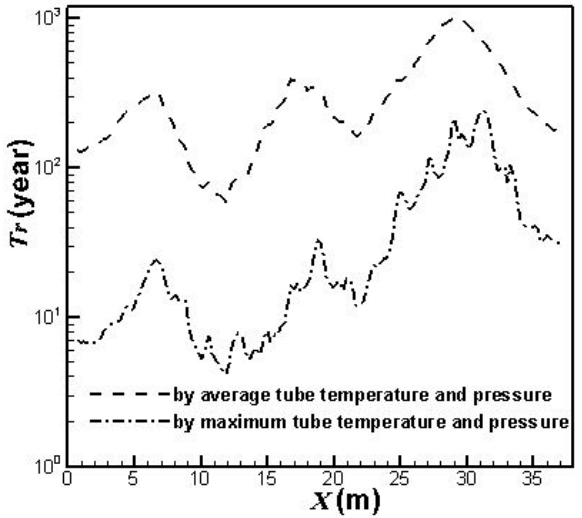
Figure 5. Lifetimes for the catalyst tubes of the prototype reformer.